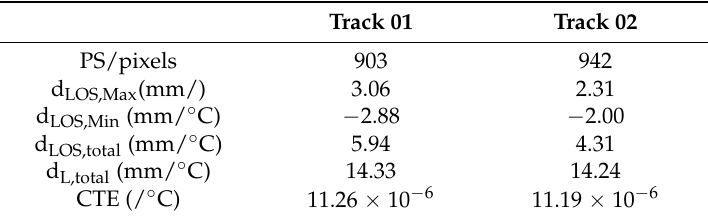
Figure 10. Average cross velocities in the longitudinal direction. The figure marked with ‘( a )’ is related to Track 01, and that marked with ‘( b )’ refers to Track 02. Table 4. Thermal dilation parameters of the